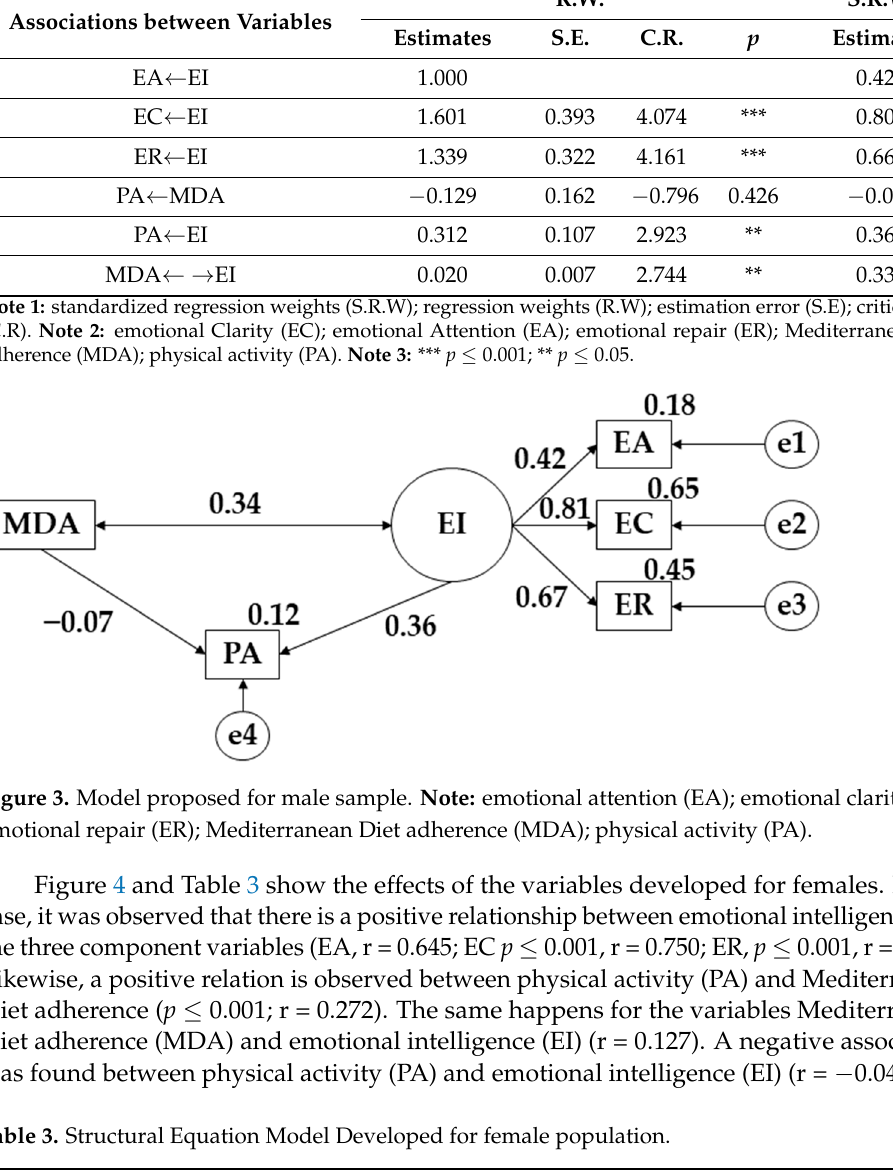
Table 3. Structural Equation Model Developed for female population. Associations between